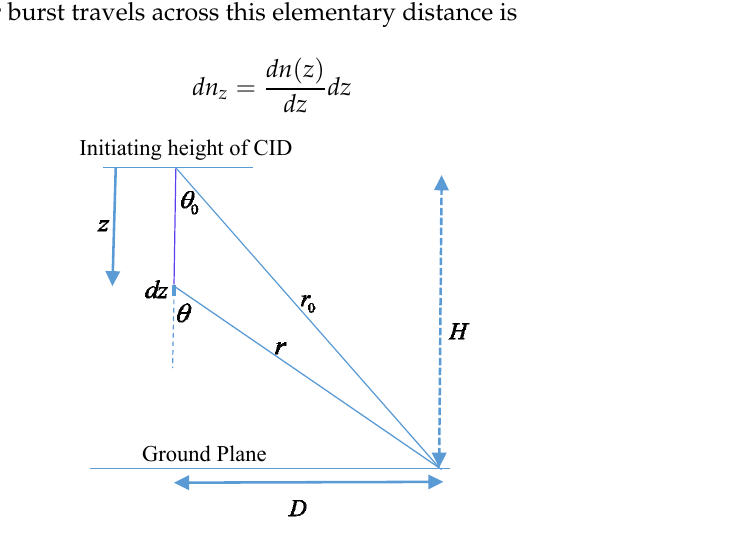
Figure 6 . Geometry relevant to the calculation of the electric field generated by the streamer burst.